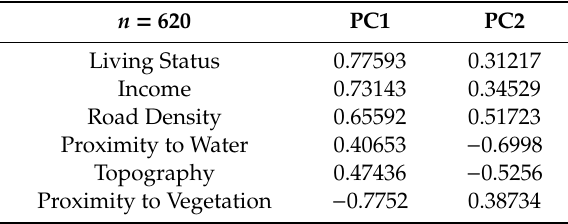
Table 2. Principal component (PC) coe ffi cients (loadings) for adaptation variables for the two principal